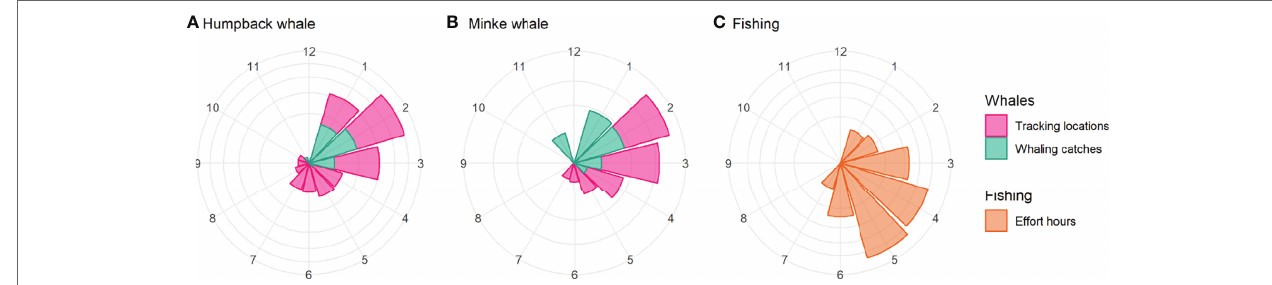
FIGURE 9 | Approximate phenology of humpback whales (A) , minke whales (B) and fisheries (C) in the Western Antarctic Peninsula by month. The figure shows an approximate comparative phenology for whales – using the monthly number of satellite tracking location estimates in the study area (magenta) and the monthly number of whaling catches south of 60° S from 1900-2015 (Allison, 2016) (cyan) – and fisheries – using the monthly hours of effort (orange). Values were normalised for presentation, and the y-axis is square root-transformed. The whale phenology will be biased towards tagging activity during the summer and autumn, and whaling catches will be biased against catches in winter and spring. Minke whales (Antarctic and common) were only caught in large numbers from around 1960 onwards, around which time humpback whale catches declined (Rocha et al.,